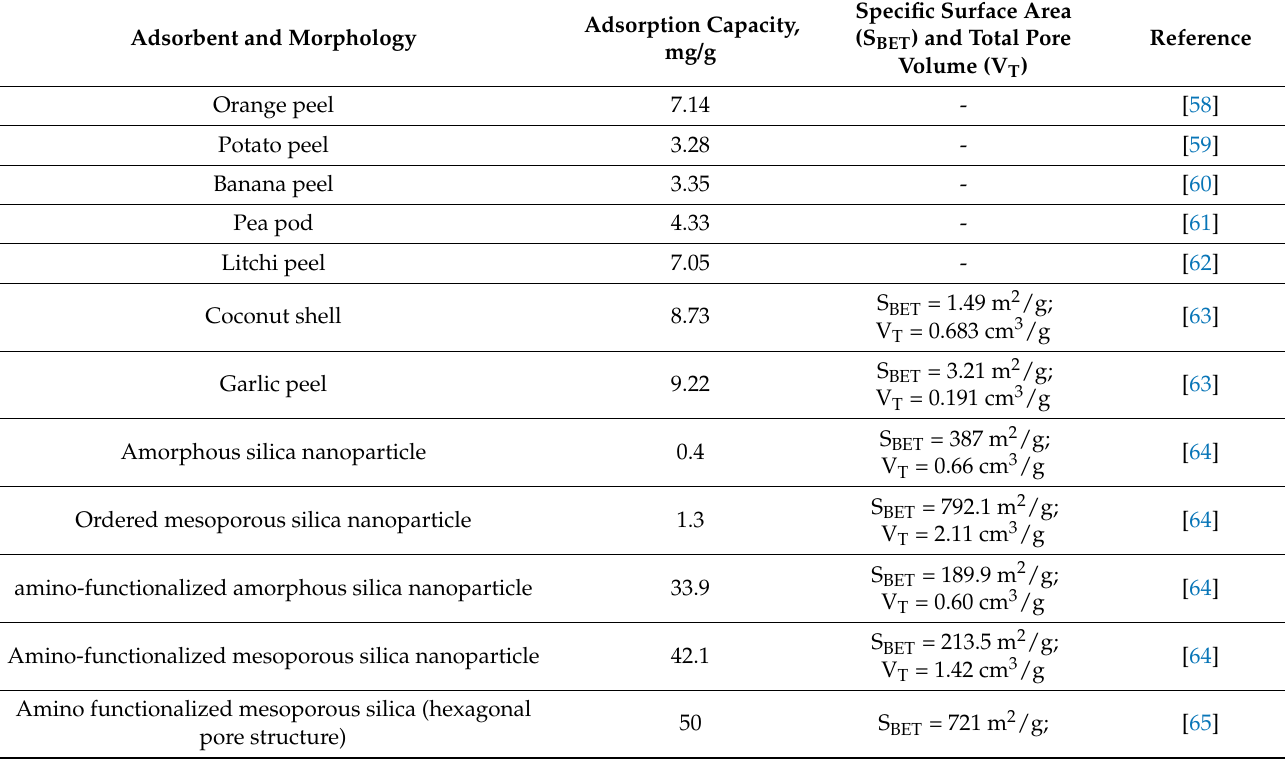
Table 5. Adsorption capacities of some adsorbents used for Cr(VI) ions removal, their morphologies, specific surface area, and the total pore volumes, cited in recent